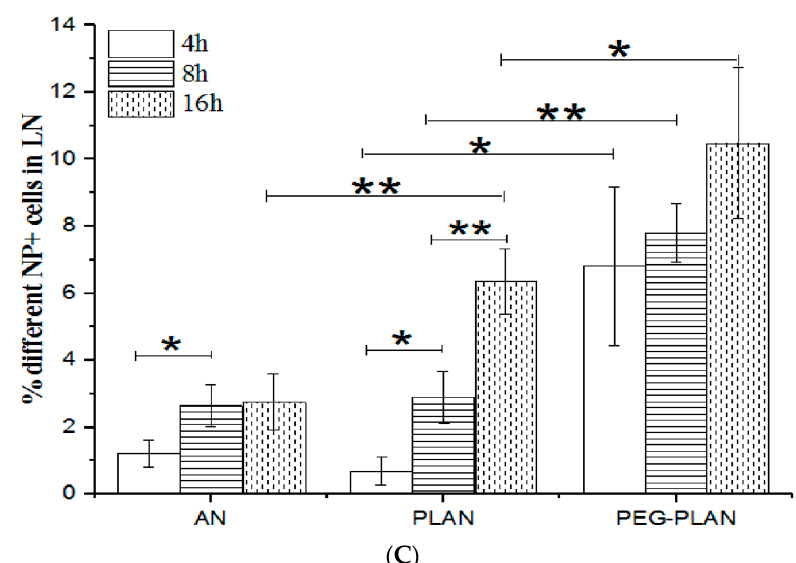
Figure 4. In vivo tracking of the calcein-labeled aluminum oxide nanoparticles (ANs), PLANs, and PEG-PLANs administered subcutaneously to mice at the lower extremity of lateral thigh ( n = 3). ( A ) Fluorescent images of the cryo-sections of inguinal LNs separated from the mice that had been burdened with the Al-based carriers for different times. ( B ) The uptake frequencies of different calcein-labeled Al-VADSs by draining LN immunocytes at different times were estimated by flow cytometry. ( C ) The significant differences of cellular uptake of different Al-VADSs by draining LN immunocytes at different times were analyzed by t-test. (* p -value < 0.05, ** p -value < 0.01).